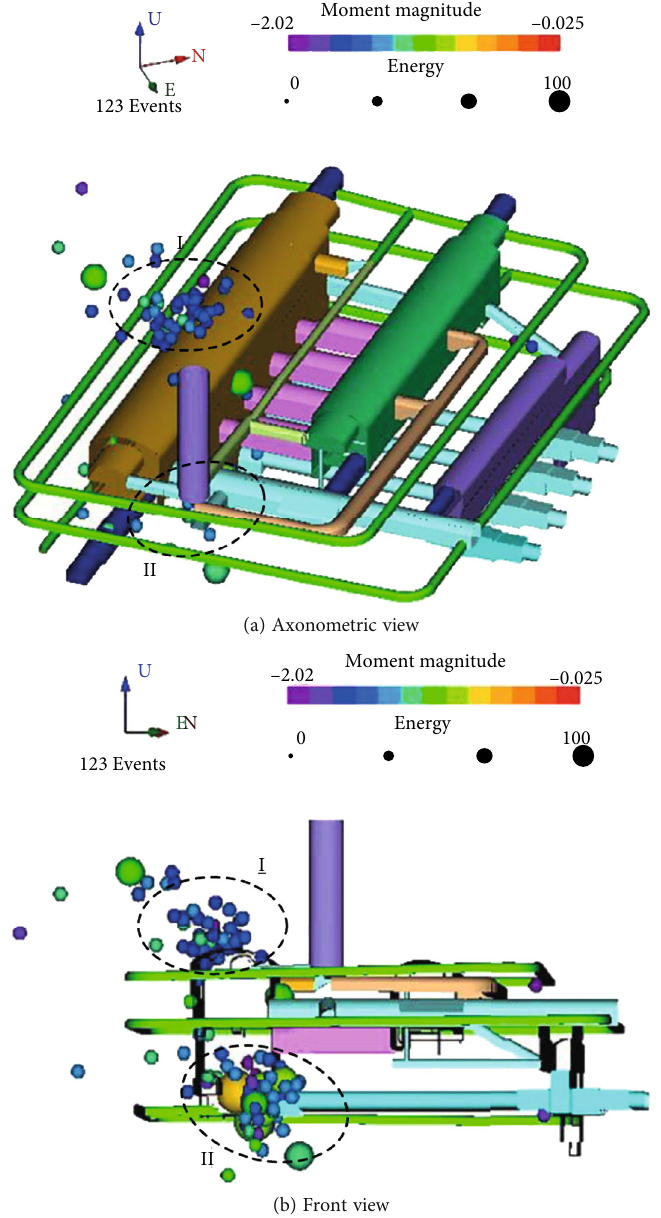
Figure 10: Spatial distribution of microseismic